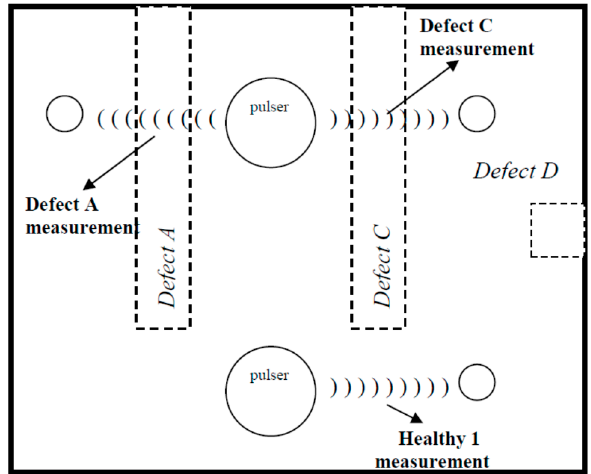
Figure 5. Sensor placement in assessing defects A and C.